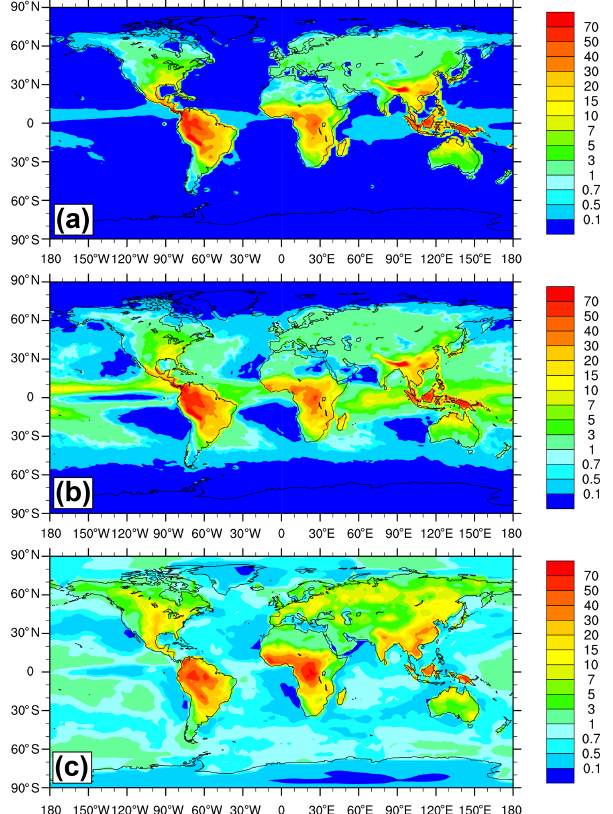
Figure 6. Global distribution of the annual-averaged LNO x (10 − 13 kgNm − 2 s − 1 ) for the year 2006: (a) model simulation with the default PR92 flash-rate parameterisations (Run 1), (b) model simulation with the new flash-rate parameterisations from this study (Run 2), and (c) the distribution obtained by Miyazaki et al. (2014, plot redrawn) using assimilation of multiple satellite datasets into a global CTM for the year 2007. The respective global LNO x totals are 4.8, 6.6, and 6.3TgNyr − 1